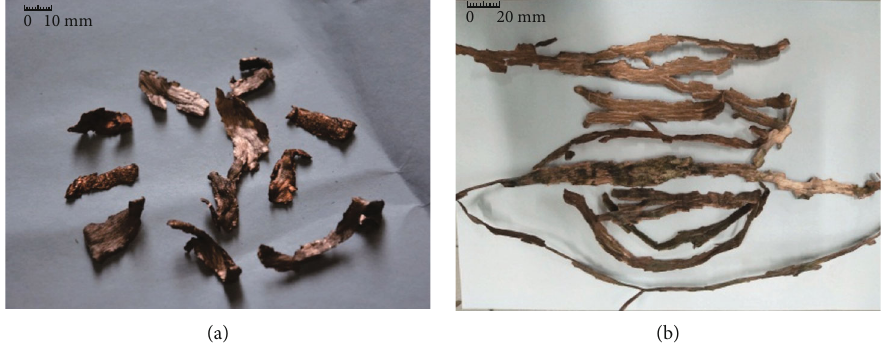
Figure 14: Recycled fragments in the